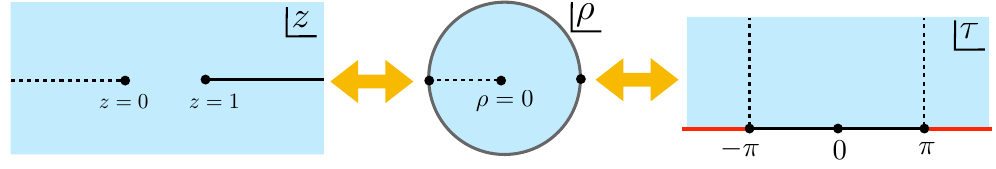
Figure 2 . Transformation from the z cut plane to the (cid:26) disk to the (cid:28) upper-half plane, see the